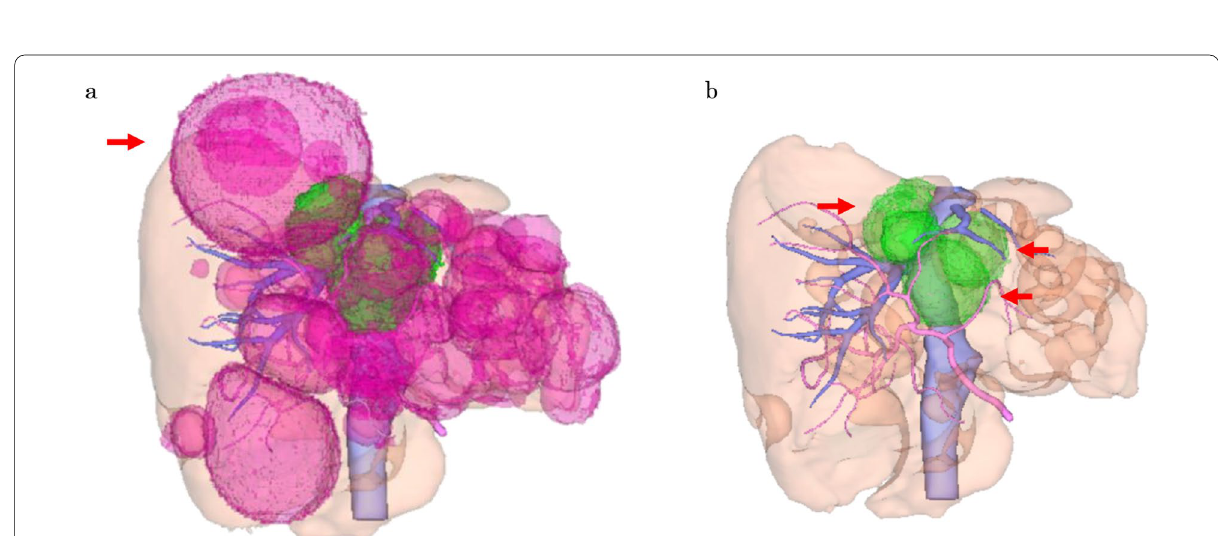
Fig. 2 Three-dimensional reconstructed image of the liver. The hemodynamically involved cysts are indicated by arrows, respectively. a Shows all cysts, and the arrow indicates the largest lesion in segment eight. b Shows cysts on both sides of the IVC and near the portal bifurcation in green (arrowheads)